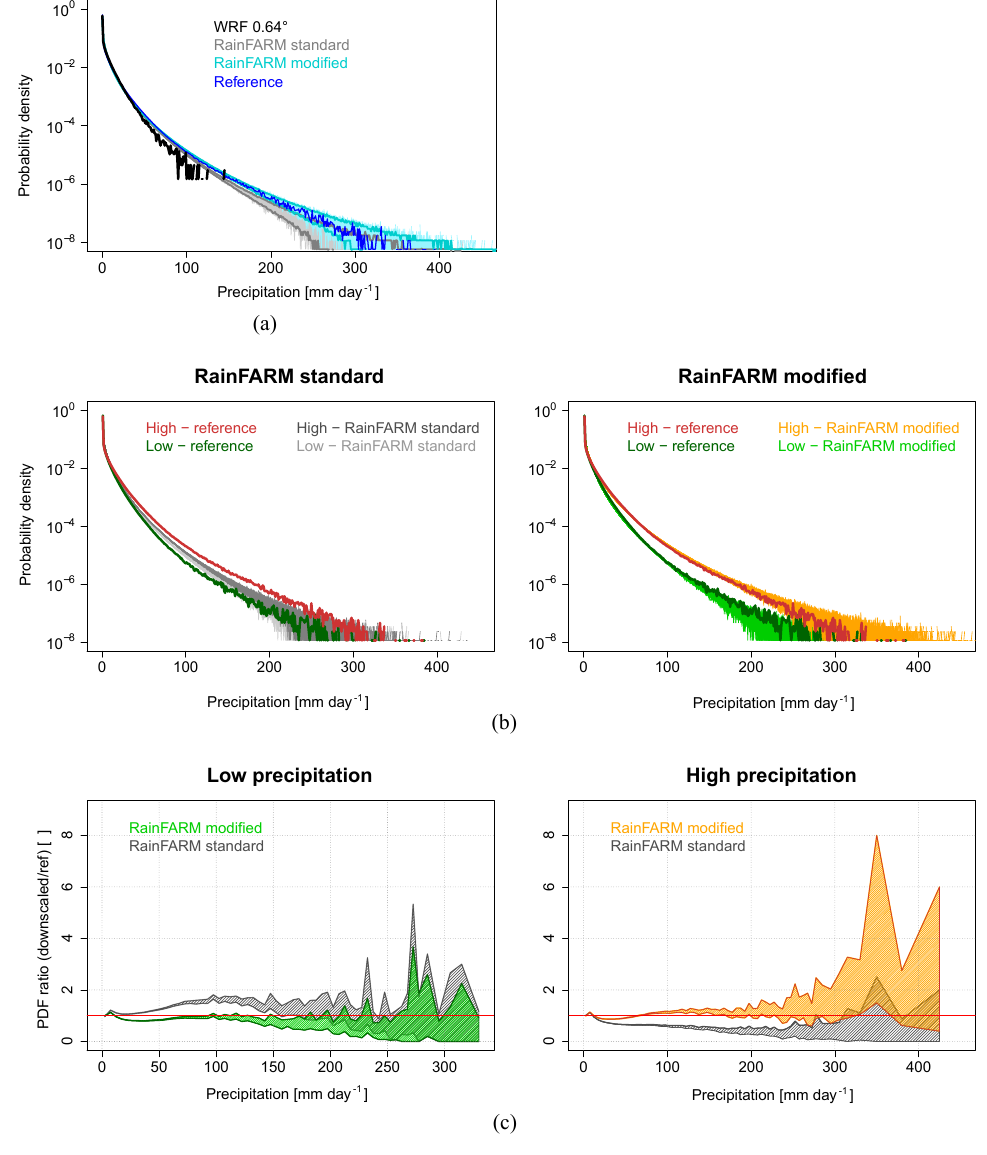
Figure 3. The “perfect-model” experiment: (a) probability density function (PDF) of WRF daily precipitation at coarse resolution (64km, black) of the downscaled WRF precipitation (from 64 to 4km) obtained using the standard (gray) and modified (light blue) RainFARM methods compared to the original fine-resolution (4km) WRF precipitation (blue). Gray and light-blue bands and lines represent the spread of the ensemble and the fifth and 95th percentile ranges, respectively, calculated from 80 realizations of the stochastic downscaled field; (b) same as (a) but separating high- and low-precipitation grid points as specified in the text; (c) ratio between the PDF of WRF downscaled precipitation and the PDF of the reference, for low- and high-precipitation grid points, with the standard and the modified RainFARM